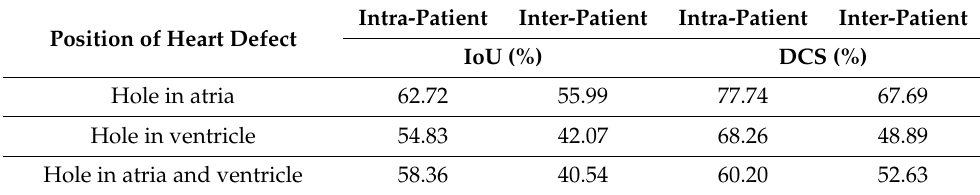
Figure 11. Fetal heart view with heart chamber segmentation in ( a ) 4CH, ( b ) 3VT, ( c ) LVOT, and ( d ) RVOT for normal heart anatomy structure. Fetal heart view boundary and heart chamber part as the same description with Figure 10. Table 5. The IoU and the DCS performance for heart defect